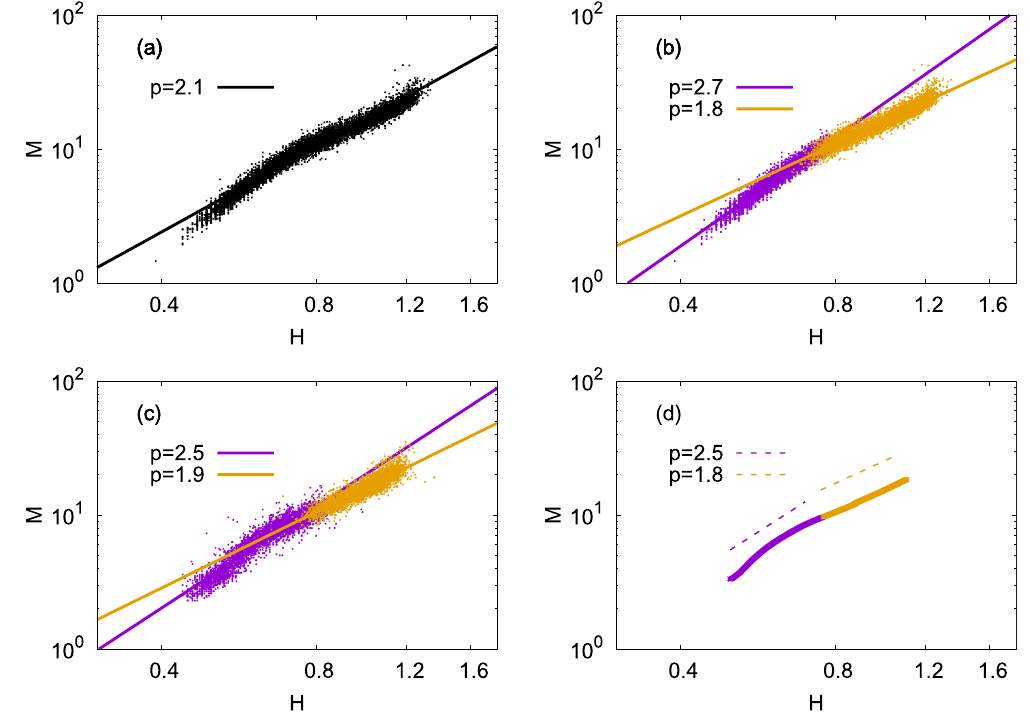
Figure 2. The mass M and the height H for humans: ( a ) and ( b ) for the data from Sweden, ( c ) from Korea, and ( d ) from WHO (see text for details of the used datasets). The linear regression for the entire data in ( a ) for Swedish children gives the Benn index p = 2.1. In ( b ), we divide all Swedish data into two groups depending on whether the child is younger or older than one year after birth. The left part of the data for children younger than one year old has p ≈ 2.8 while children older than one year (the right part of the data) has p ≈ 1.8. ( c ) Data for Korean children drawn in the same way as for ( b ), giving us p ≈ 2.5 and p ≈ 1.9 depending on the age group (younger and older than one year, respectively). ( d ) WHO data displayed in the same way. Again, we see the change of p value at around one year after birth. Although all data points in each dataset are used to perform the linear regressions in ( a )–( c ), we use only 10000 randomly chosen points in each scatter plot for ( a )–( c ), only for convenience of